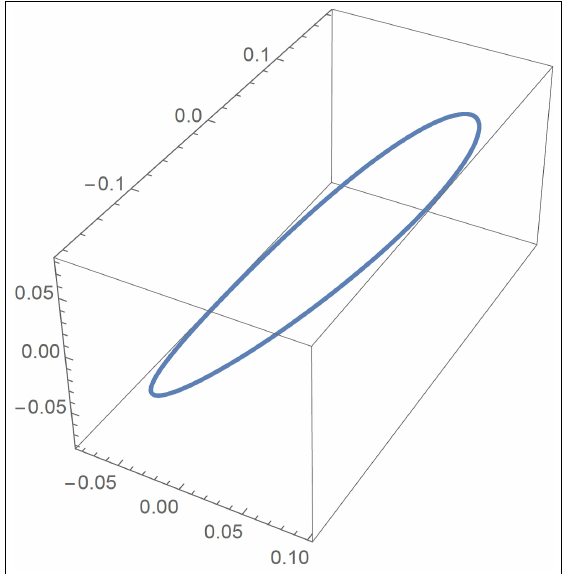
Fig. 5 Deputy 3D parametric